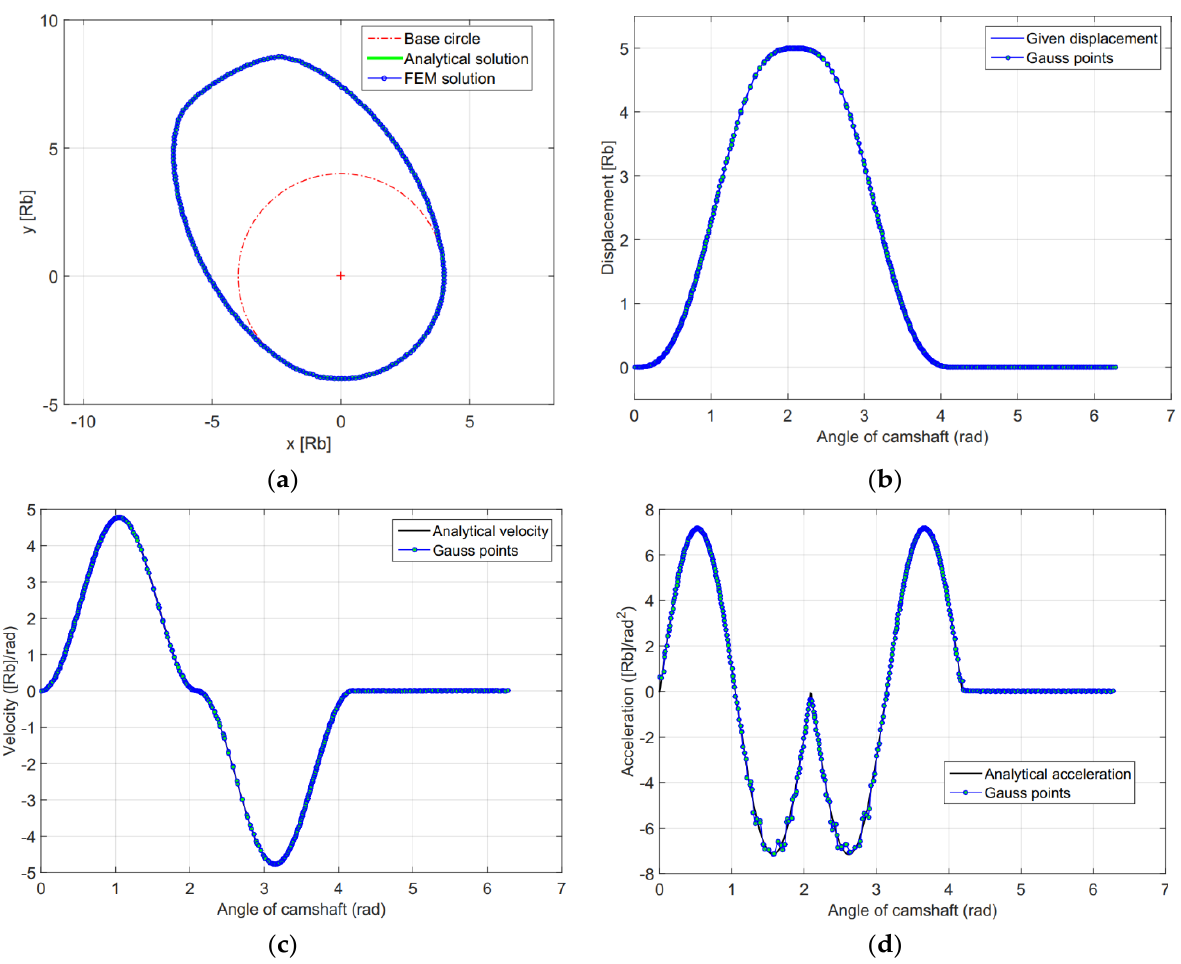
Figure 5. Compare between FE solution with 128 elements and analytical solution ( a ) comparison of cam profile; ( b ) comparison of displacement; ( c ) comparison of velocity; ( d ) comparison of acceleration.